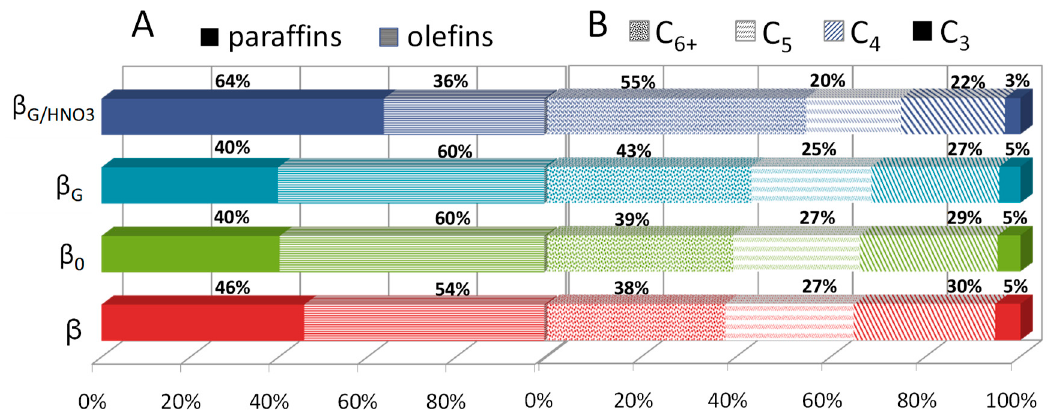
Figure 5. Distribution of paraffinic (solid symbols) and olefinic (pattern symbol) products ( A ) and the selectivity of the LDPE cracking over zeolites Beta studied ( B ).